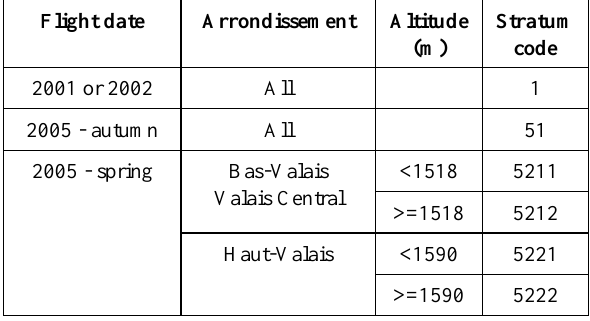
Table 2. Strata for model calibration For model calibration, NFI plots located across ALS tiles acquired in different years or seasons are discarded (24 plots). Plots with missing or partial point clouds (altitude superior to 2100 m) are also discarded (32 plots). A visual comparison of the point cloud and corresponding NFI data was performed to remove NFI plots where the temporal or spatial difference between field and airborne acquisition leads to a flagrant discrepancy (15